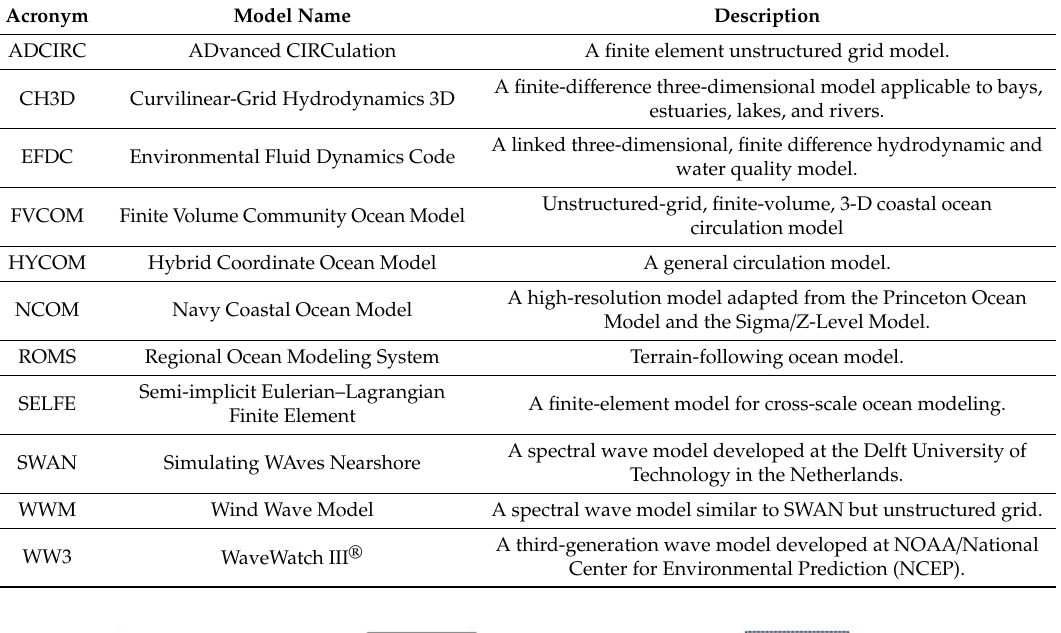
Table 2. Circulation models applied in the Coastal Ocean Model Testbed (COMT) program used various numerical formulations including finite di ff erences, finite elements, finite volumes; implicit and explicit time stepping and various vertical coordinate treatments (e.g., vertically integrated, z-level, terrain following, isopycnic, and hybrid). Wave models were based on a random-phase, spectral description of the ocean surface.